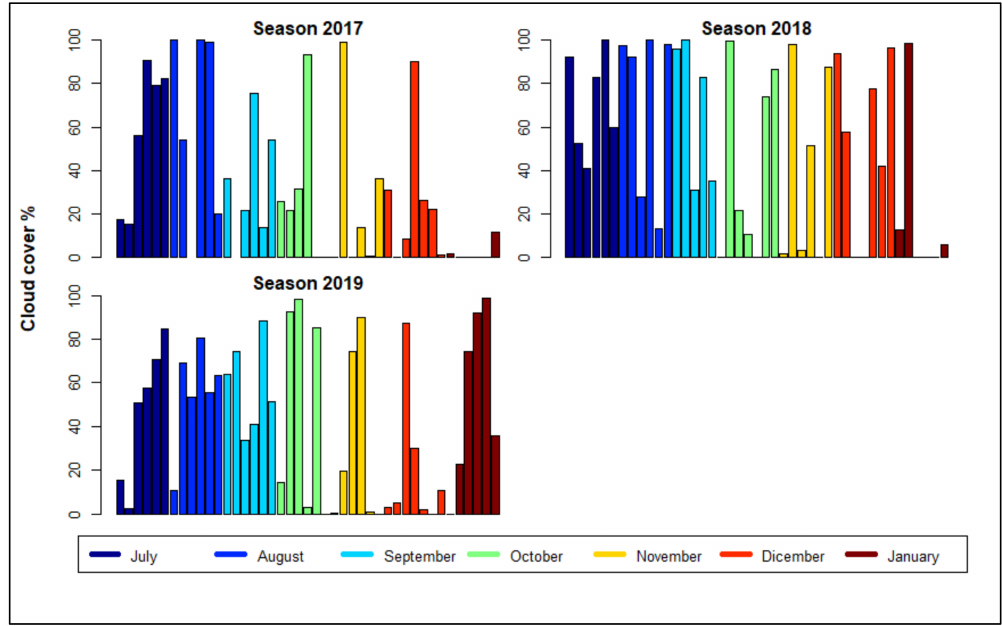
Figure 5. Percentage of cloud cover a ff ecting S2 T28PDV tile imagery (corresponding to 82% of the study area) in 2017, 2018, and 2019 seasons.